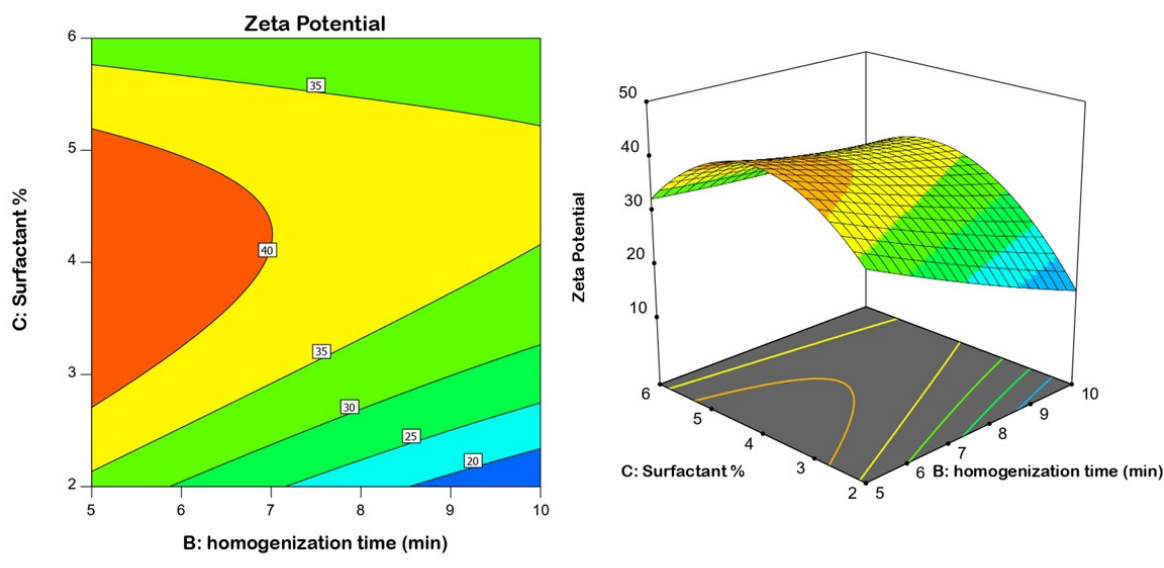
Figure 4. 2D contour and 3D response surface plots revealing the effect of surfactant % and homog- enization time at an average speed on the nanoemulsion zeta potential.